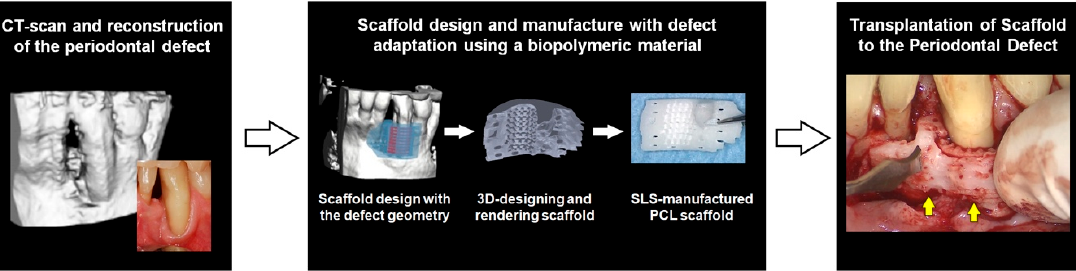
Figure 5. The clinical application for periodontal tissue regeneration using 3D printing system, selective laser sintering (SLS) technique. The scanning the labial defect image in a mandible was utilized to design a periodontal defect-fit scaffold and created by SLS 3D printing system. After sterilizing the scaffold, it was transplanted to the defect sites in the human patient. Adapted with permission from the reference [134].